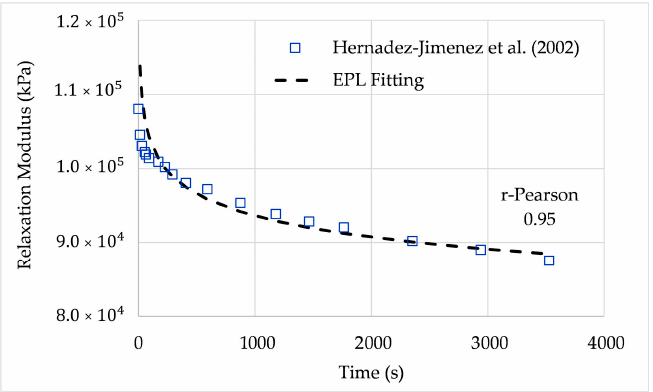
Figure 9. Relaxation modulus from Hernández-Jiménez et al. (2002) and EPL fitted curve for PMMA.